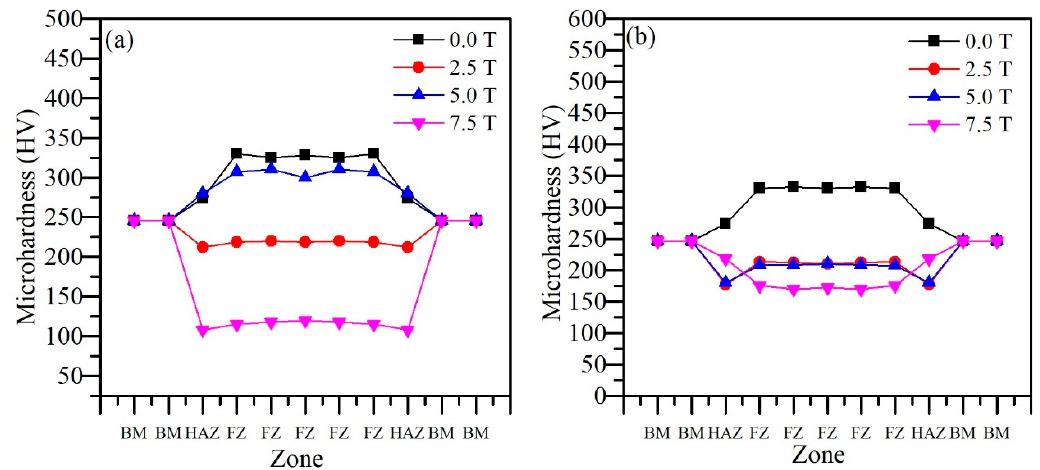
Figure 7. Evolution of Vickers microhardness at different depths in the weld bead and external magnetic field. ( a ) At a depth of 0.20 mm and ( b ) at a depth of 0.35 mm. HAZ, heat-affected zone; BM, metal base; FZ, fusion zone.